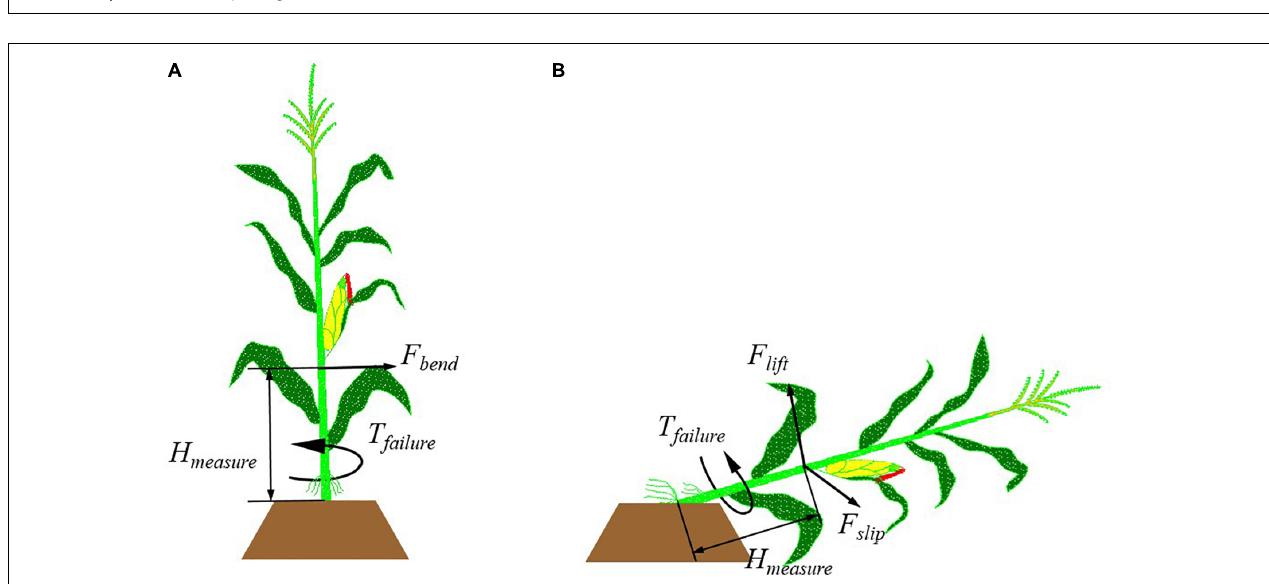
FIGURE 1 | Process of ear picking on the corn header.